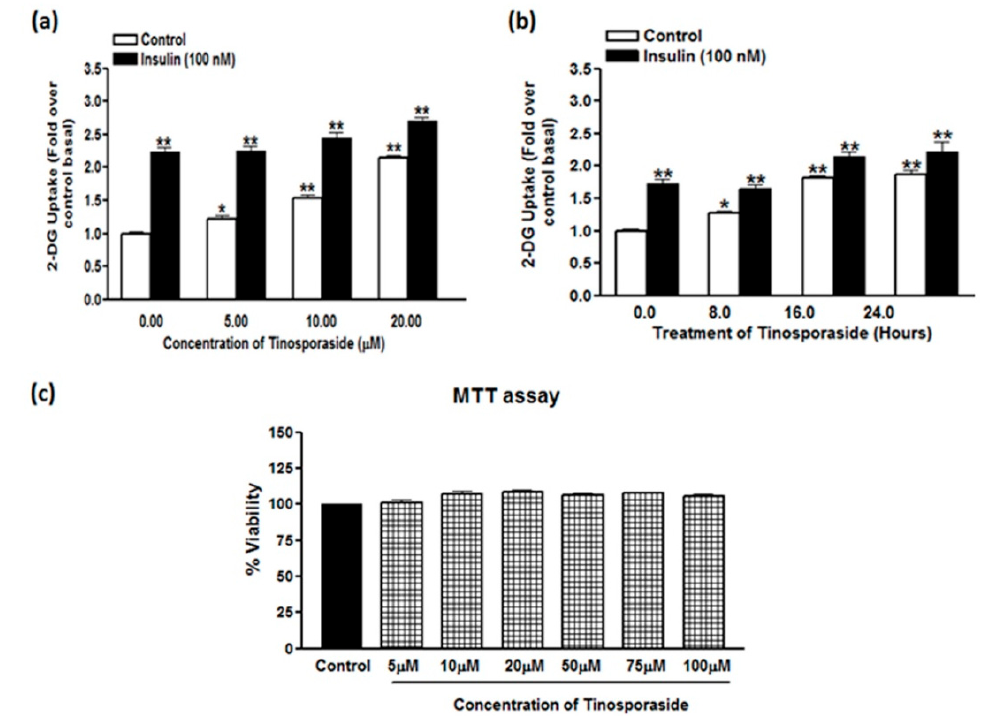
Figure 2. Dose- and time-dependent effect of tinosporaside on glucose uptake. ( a ) L6 myotubes were treated with different concentrations of tinosporaside for 16 h. After incubation, a subset of cells were stimulated with 100 nM of insulin for 20 min, which was followed by the determination of 2-DG uptake. ( b ) L6 myotubes were treated at 10 µ M concentration of tinosporaside for a different time period and 2-DG uptake was determined in absence (white bars) or presence of 100 nM insulin (black bars). ( c ) L6 cells were treated with tinosporaside for 24 h at different concentrations, from 5 µ M to 100 µ M, and cytotoxicity was measured using the MTT assay. Results are expressed as fold stimulation over control basal. Results shown are mean ± SE of three independent experiments. * p < 0.05, ** p < 0.01, relative to control basal.